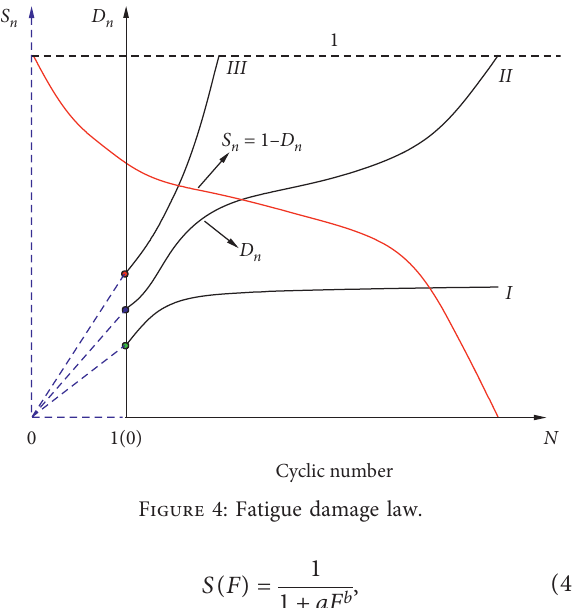
Figure 4: Fatigue damage